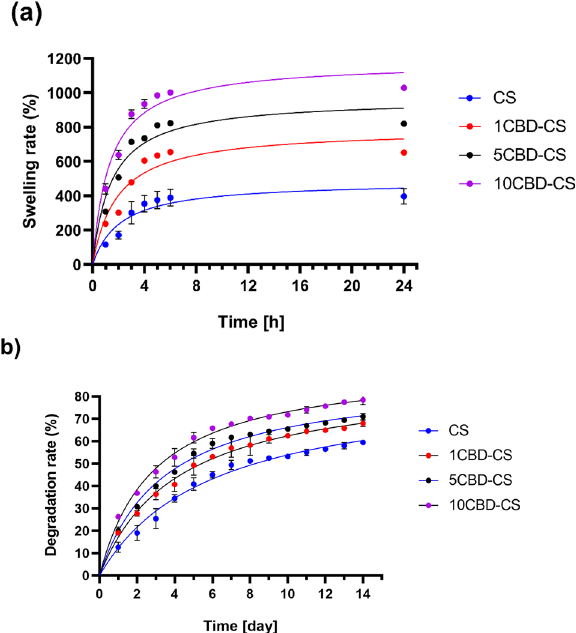
Figure 5. ( a ) Swelling and ( b ) degradation studies of the obtained films, where 1, 5, 10CBD-CS corresponds to the weight ratio of 1, 5 or 10% of cannabidiol oil (CBD) to chitosan